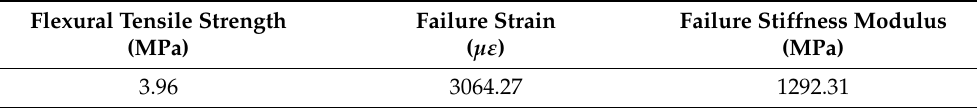
Table 7. Results of the small beam bending test at − 10 ◦